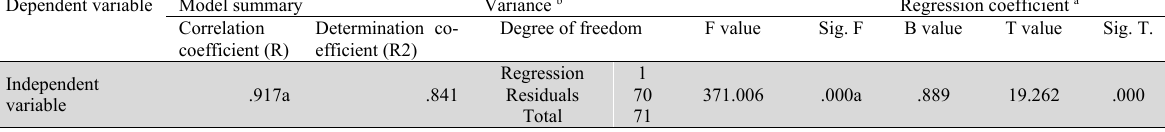
The results of the simple regression analysis for testing the third sub-hypothesis Dependent